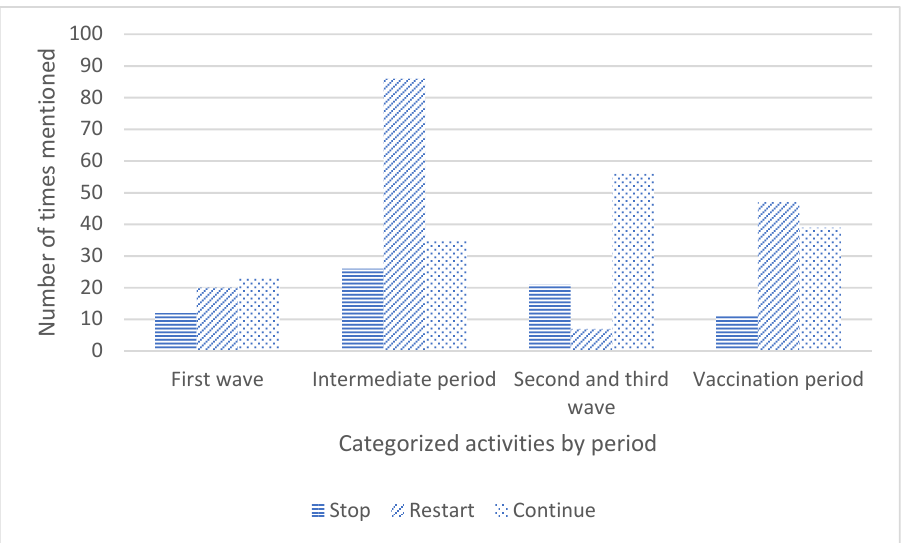
Figure 1. Flowchart of the included textual units per time period. Note : T1 is the first wave, T2 is the intermediate period, T3 is the second and third wave, and T4 is the vaccination period. * Exclu- sion criteria were: activities with a therapeutic aim, not in long-term care, concerning family care- givers and volunteers without mentioning activities, or were unclear.